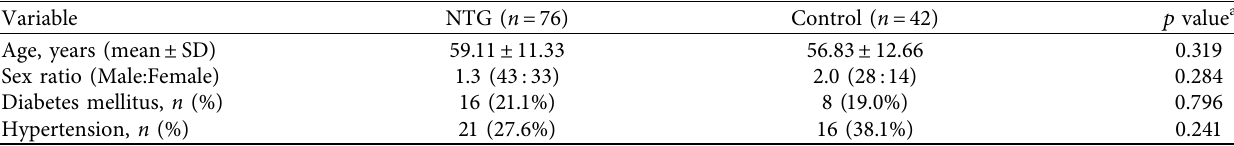
Table 1: Demographics of the NTG and control groups.